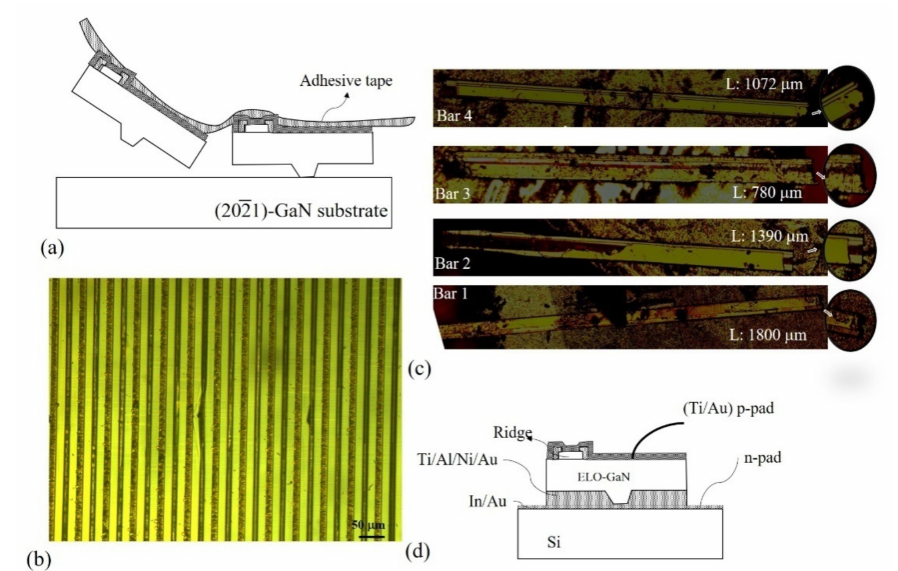
Figure 2. ( a ) Removing illustration of ELO wing LDs with adhesive tape. ( b ) Removed {2021} ELO wing LDs on adhesive tape, upside down, before n-contact deposition. ( c ) Random-length ELO wing LDs placed on a Si carrier for measurements, with magnified end facet. ( d ) Probing scheme for type-1 (handmade) facet